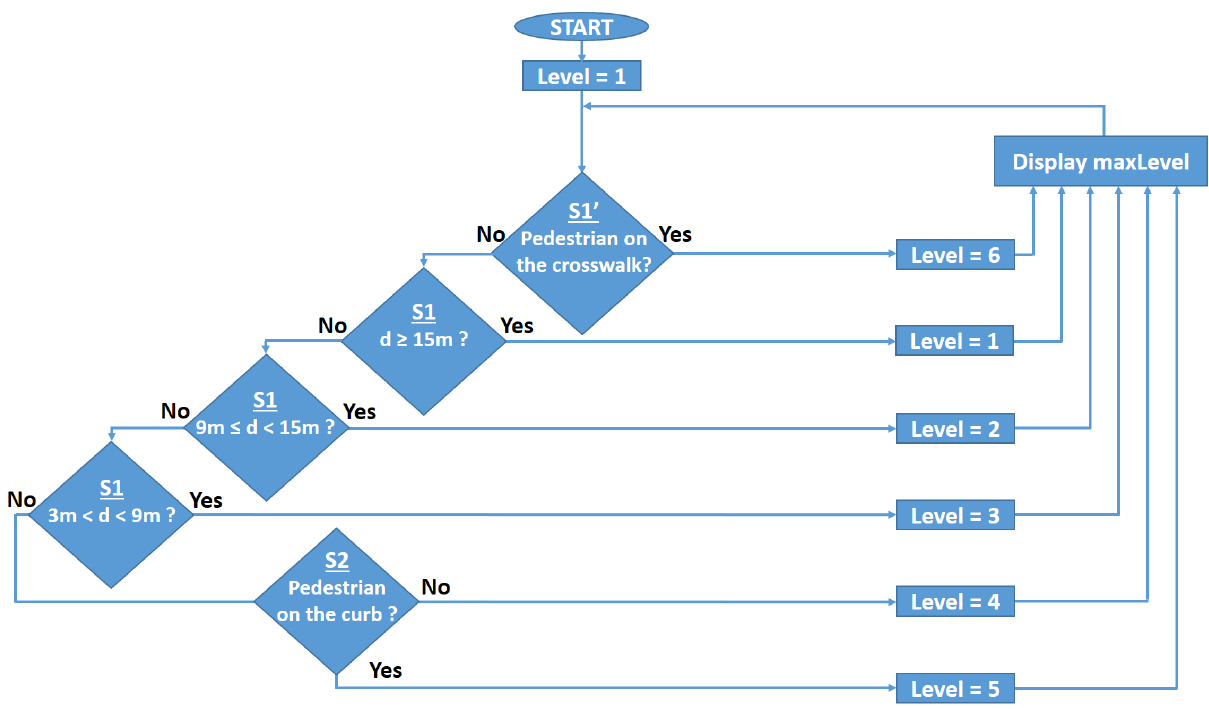
Sensors 2022 , 22 , x FOR PEER REVIEW 14 of 26